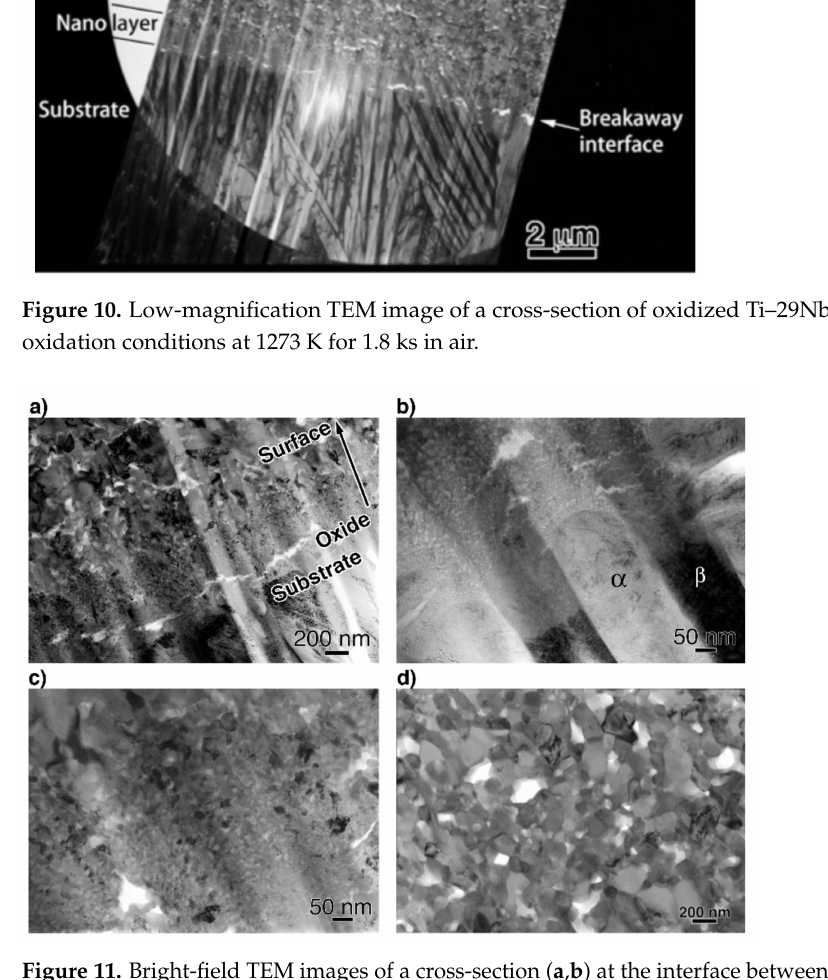
Figure 11. Bright-field TEM images of a cross-section ( a , b ) at the interface between the substrate and oxide layer, ( c ) at transition layer, and ( d ) at the oxide layer. The oxidation conditions at 1273 K for 1.8 ks in